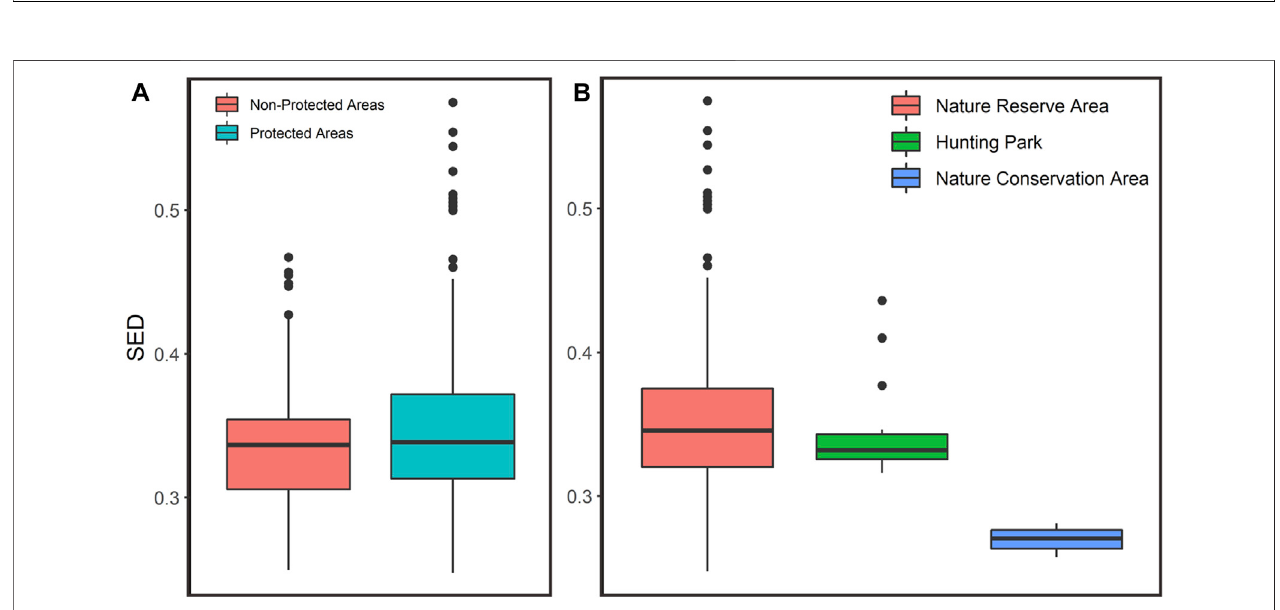
FIGURE 2 | Projected climate change in the Leuser Ecosystem based on climate change metrics. The maps show projections of change based on business-as- usual scenario (SSP585) by 2050. The metrics depicted characterize three dimensions of climate change: the magnitude of local changes in standardized climate anomalies (A) , change in the probability of extreme climates (B) , and climate change velocity, either forward (C) or backward (D) velocities. Gray- fi lled histograms indicate the statistical distributions of climate velocities.